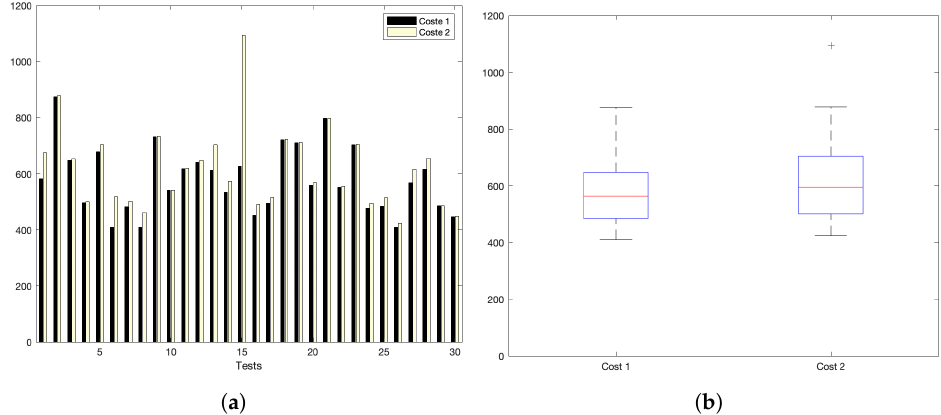
Figure 5. Low request rate: ( a ) individual test values for cost 1 and cost 2 ; ( b ) summary values.